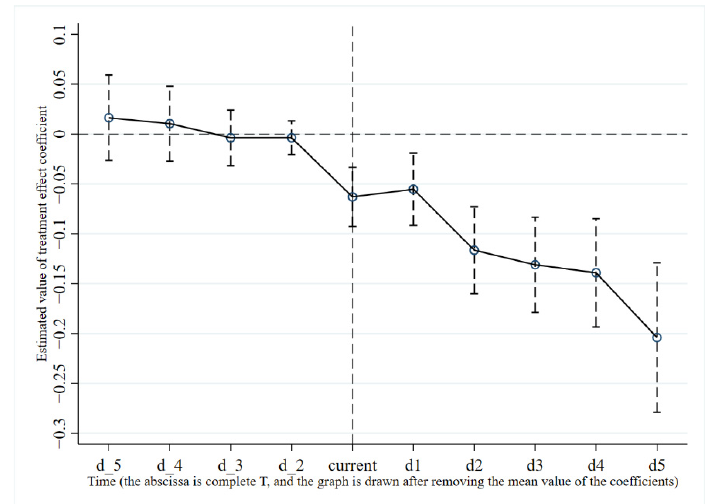
Figure 4. Parallel trend test.